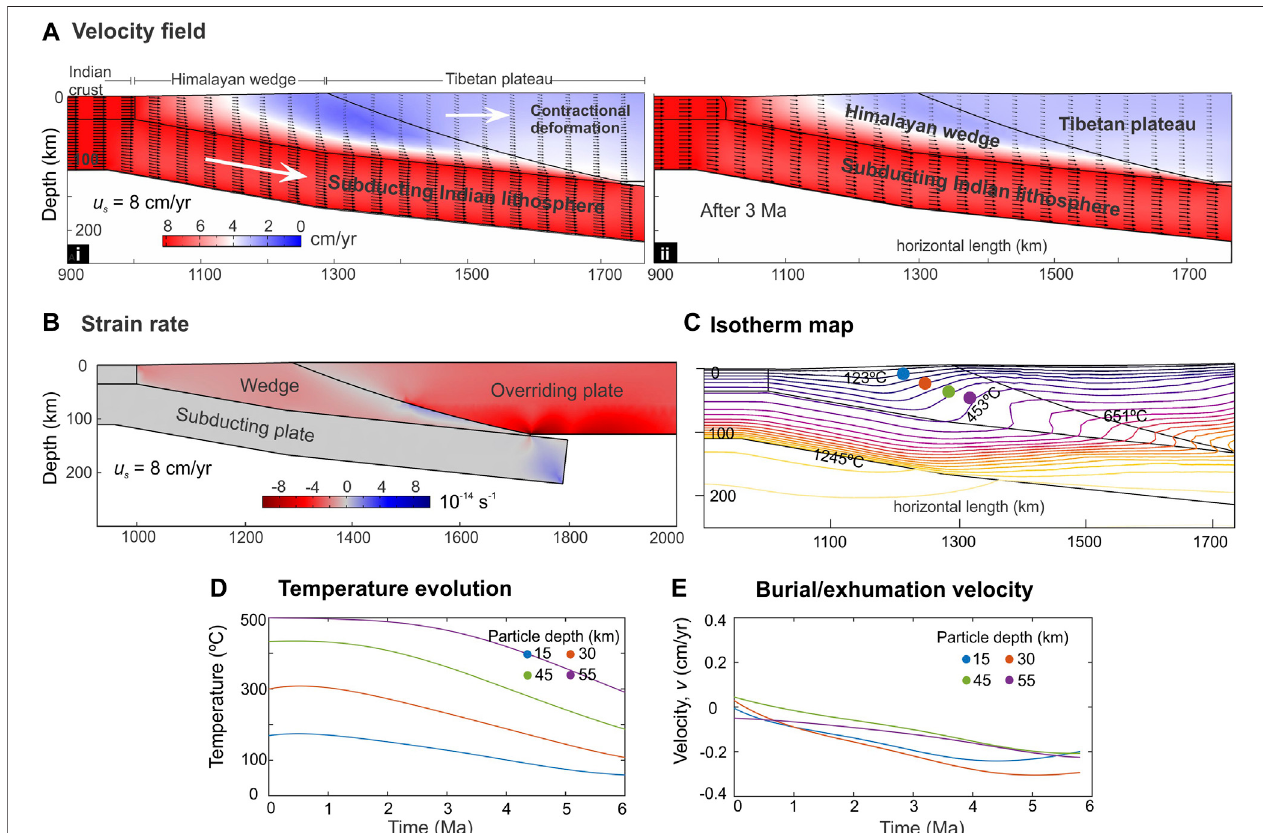
FIGURE4|(A) Calculatedplotsofthemagnitudesofvelocityvectors,obtainedfromnumericalsimulationswith u s (cid:1) 8 cm/yr. (B) Graphicalplotsofthehorizontalstrain rates( _ ε xx )for u s (cid:1) 8 cm/yr.Inthestrain-ratemaps,thecolorbarindicatespositivevaluesforextensionandnegativevaluesforcontraction. (C) Isothermmapafter4 Maofthe modelrunwith u s (cid:1) 8 cm/yr.Notethespectaculardownwardde fl ectionoftheisothermswithinthewedgeduetosubductionandfastburialoflow-temperatureuppercrustal rocks. (D, E) Temporal variations of temperature and burial/subduction velocity at some selected points (locations shown in panel (C) ) in the wedge.